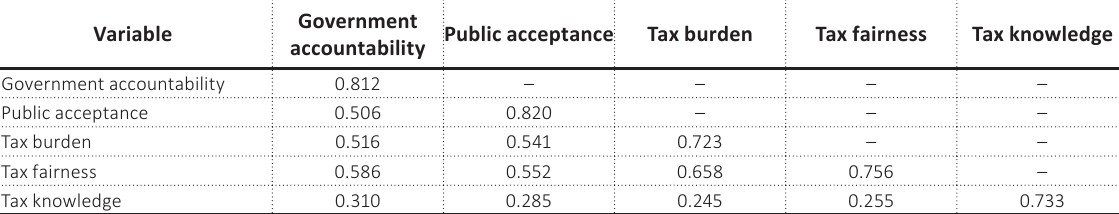
Table 4. Discriminant validity – Fornell-Larcker criterion